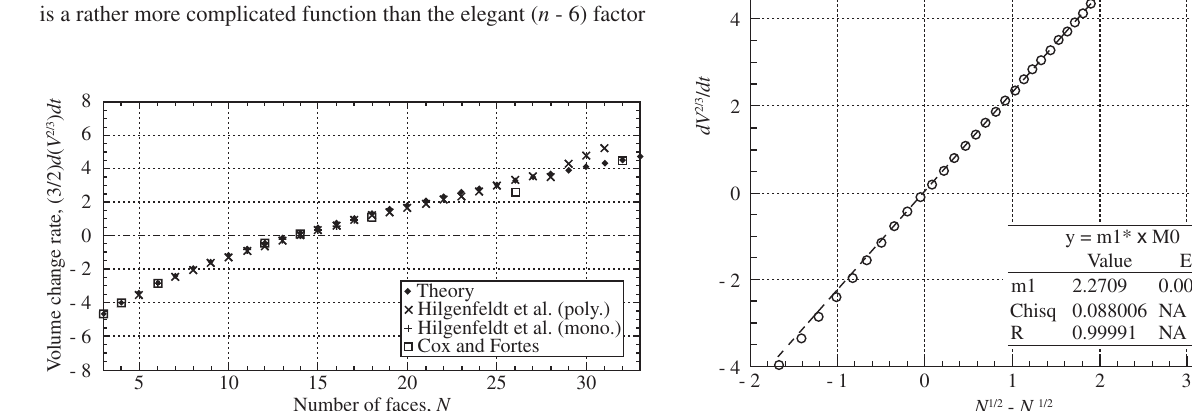
Figure 7. Linear regression of (1/ M γ )/ dV 2/3 / dt vs. ( N 1/2 - N agreement between the exact values, Equation 23, and the straight line, Equation